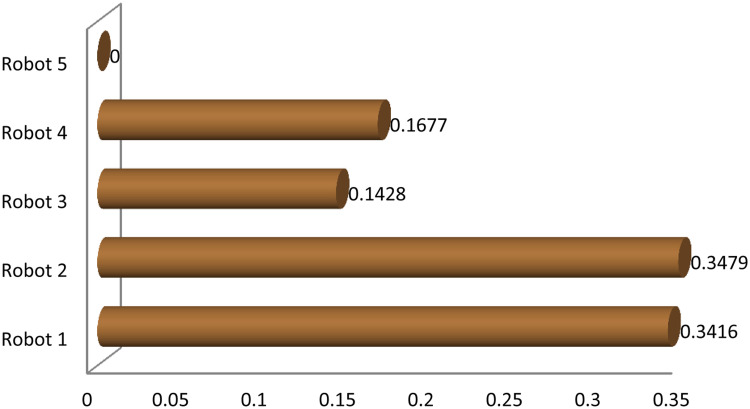
Sensitivity analysis of the criteria C3.